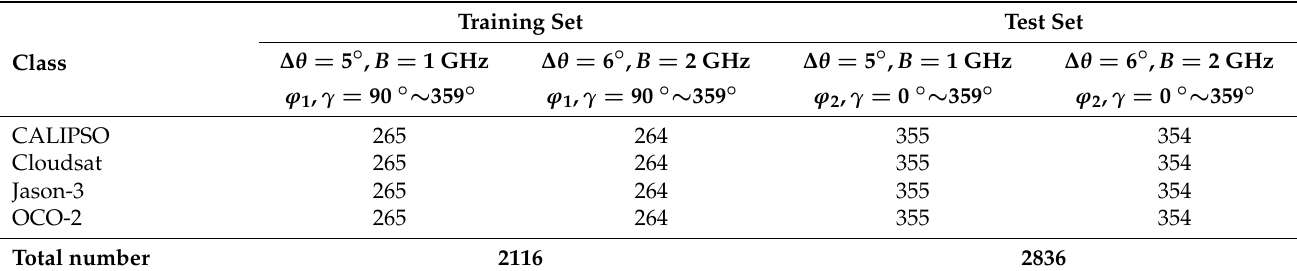
Table 2. Detailed parameter settings of training and test sets for the rotated deformation dataset.